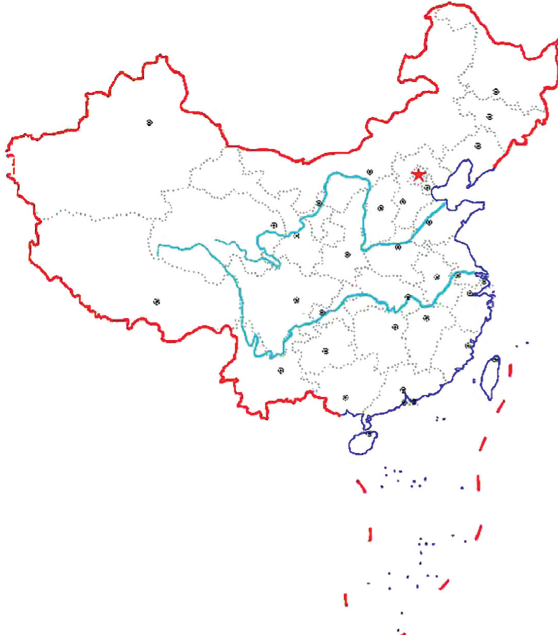
Figure 1: Location of Beijing (from the